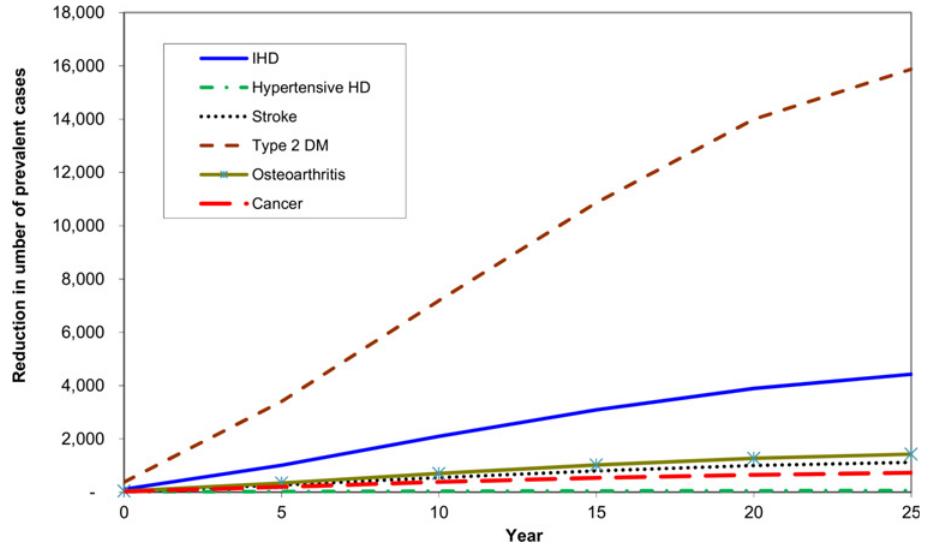
doi:10.1371/journal.pone.0151460.g003